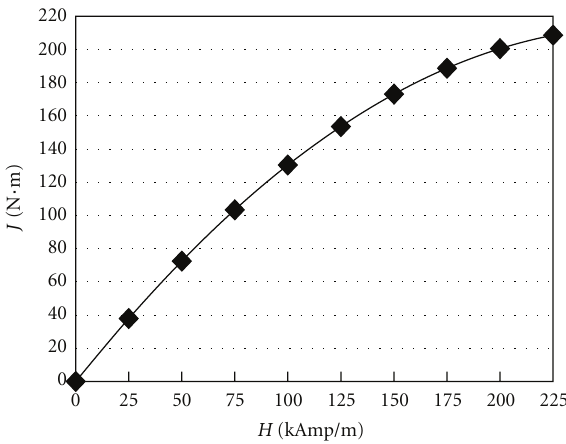
Figure 6: Transmission torque under di ff erent magnetic field strength.